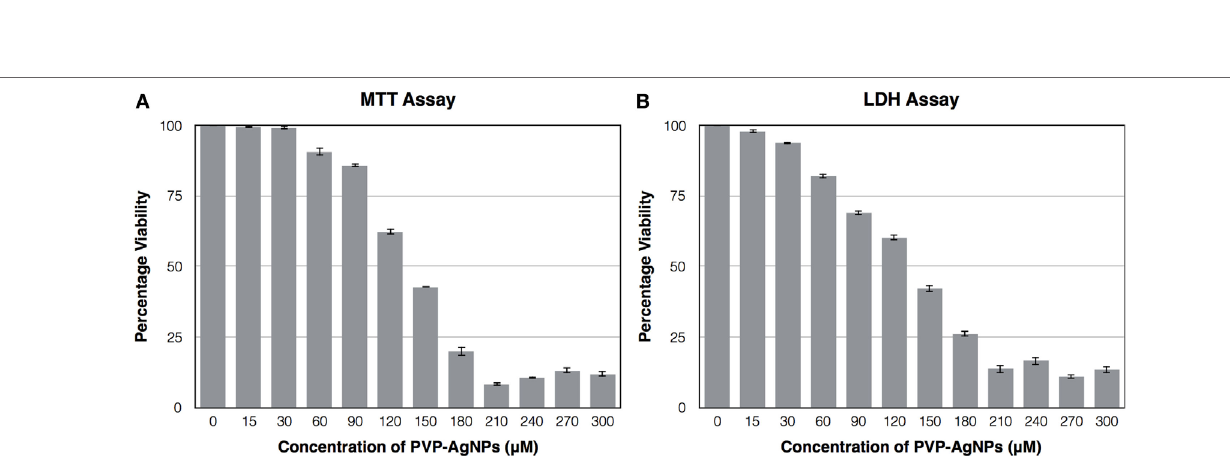
FigUre 4 | Effect of different concentration of PVP-capped AgNPs on the viability of A-549 cell line using MTT assay (a) and LDH assay (B) . The experiments were performed in triplicate and data are presented as mean ±